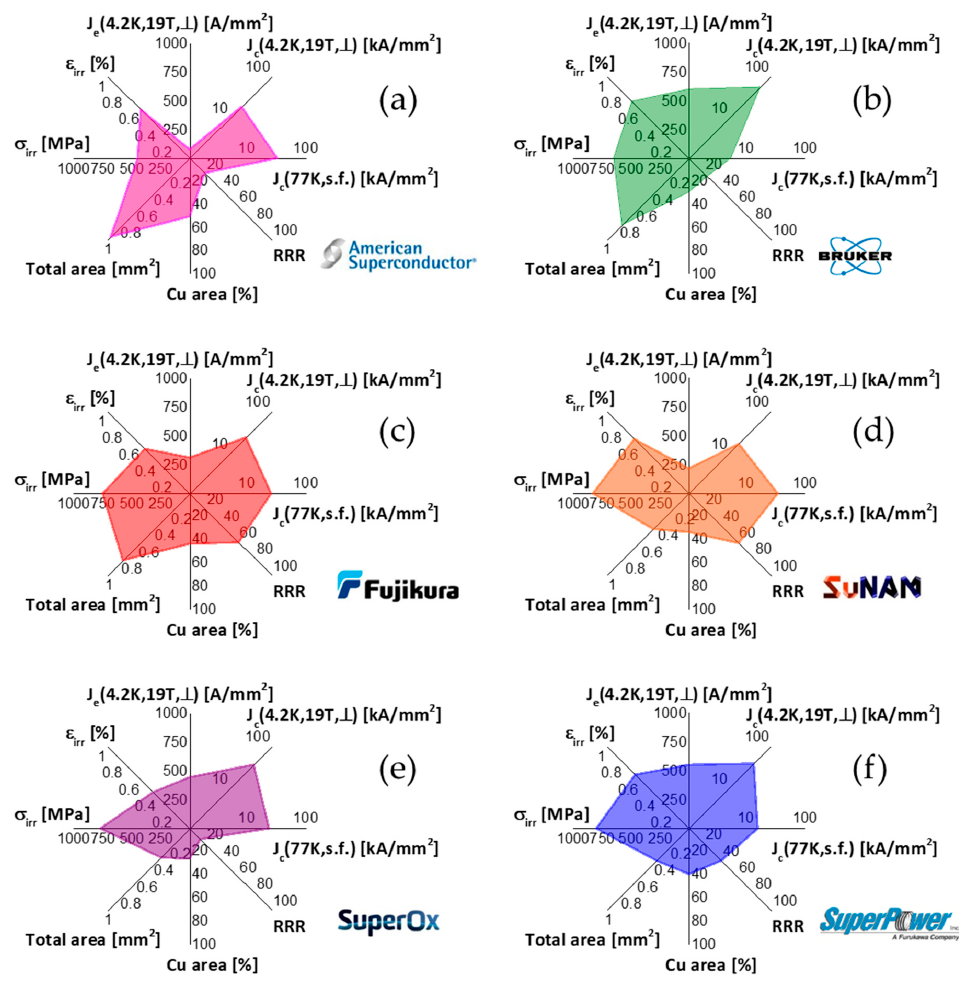
Figure 10. Radar charts summarizing the main properties of REBCO tapes from six industrial manufacturers: American Superconductor ( a ), BHTS ( b ), Fujikura ( c ), SuNAM ( d ), SuperOx ( e ), and SuperPower ( f ). The reported parameters compiled from Refs. [36–38] are the engineering current density J e (4.2 K, 19 T) and the current density in the REBCO layer J c (4.2 K, 19 T) in the perpendicular field orientation; the engineering current density J e (77 K, self-field); the residual resistivity ratio (RRR); the area fraction of the Cu stabilizer (Cu area), the total cross-section area of the tape (total area); the irreversible longitudinal strain limit, ε irr ; and the irreversible longitudinal stress limit, σ irr .